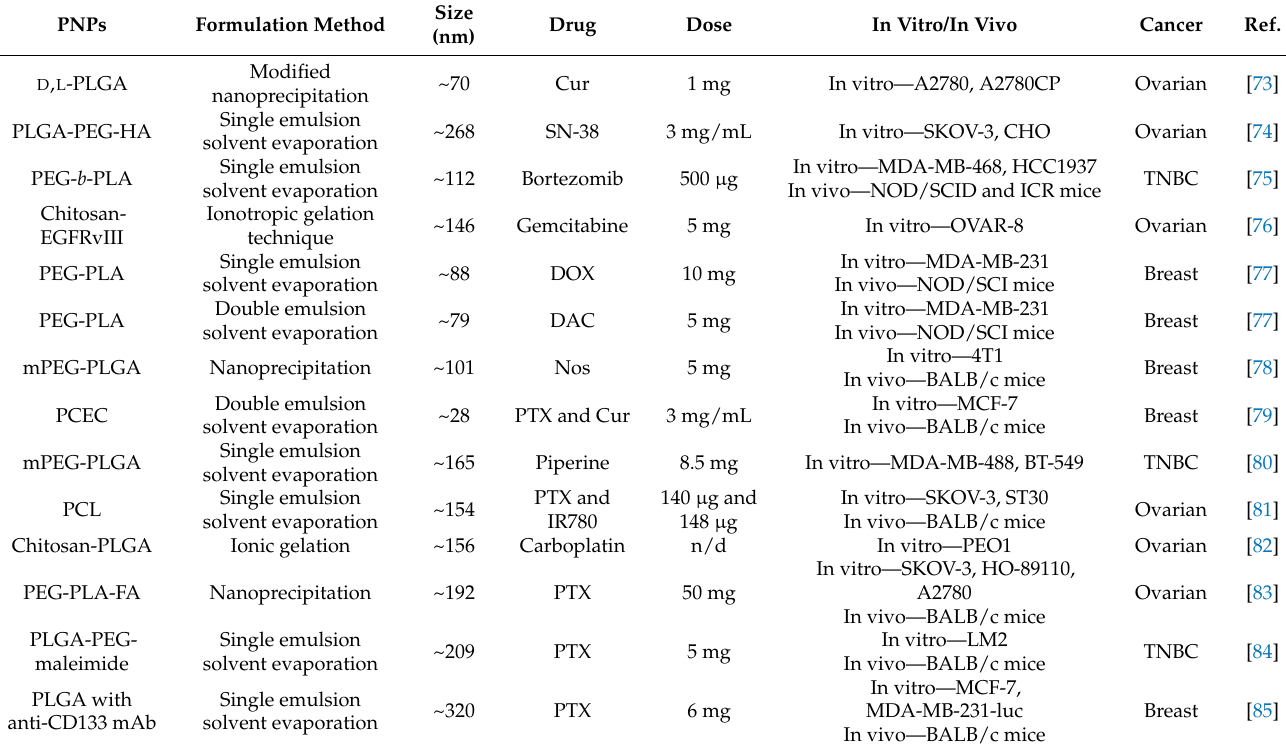
Table 4. PNPs as a drug delivery system in breast and ovarian cancer